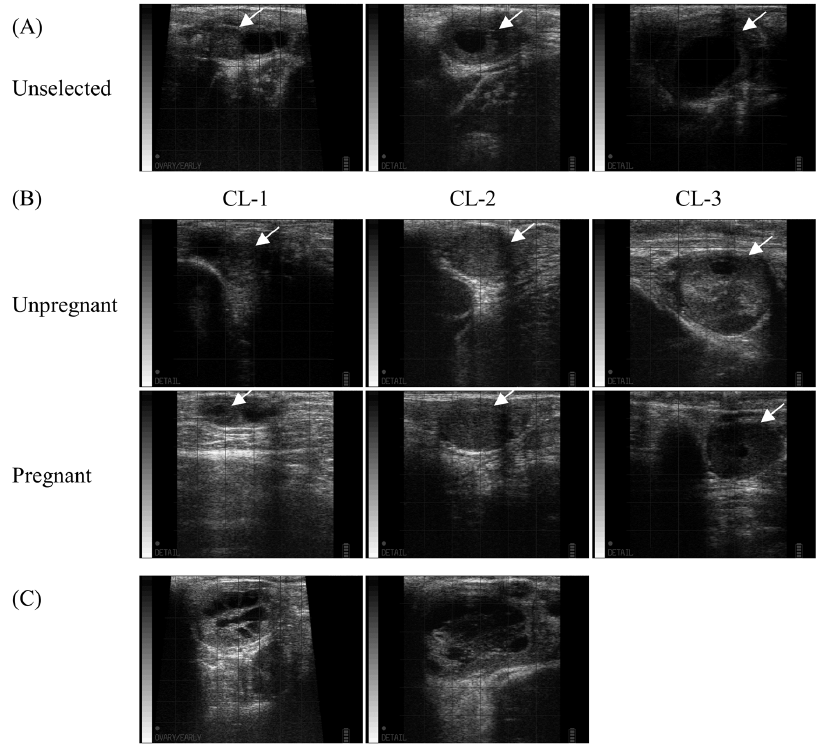
Figure 2. Corpus luteum (CL) of unselected, unpregnant, and pregnant recipients. The ultrasound CL images of were recorded the day before ET, and the operator performed ET without any notification of the evaluation results. ( A ) The candidates with poor ovarian structures palpated by rectal examination were excluded. ( B ) The representative figures of the selected recipients are shown in each category according to the pregnancy and CL size: CL-1 ( ≤ 1.5 cm), CL-2 (>1.5 cm and ≤ 2.5 cm), and CL-3 (>2.5 cm). White arrows indicate the presence of CLs. ( C ) Among the selected recipients, two had cavitary CL with high P4 concentrations, but were not pregnant.